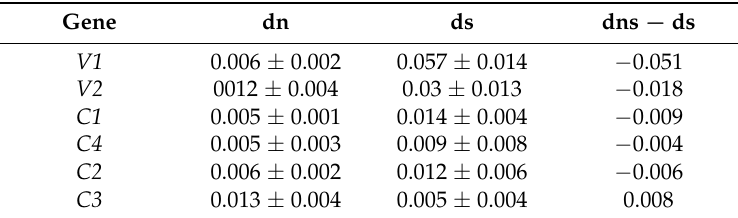
Nucleotide diversity values for the different TYLCV genes, calculated using the Pamilo–Bianchi–Li method [35,36]. Results are expressed as mean ± standard